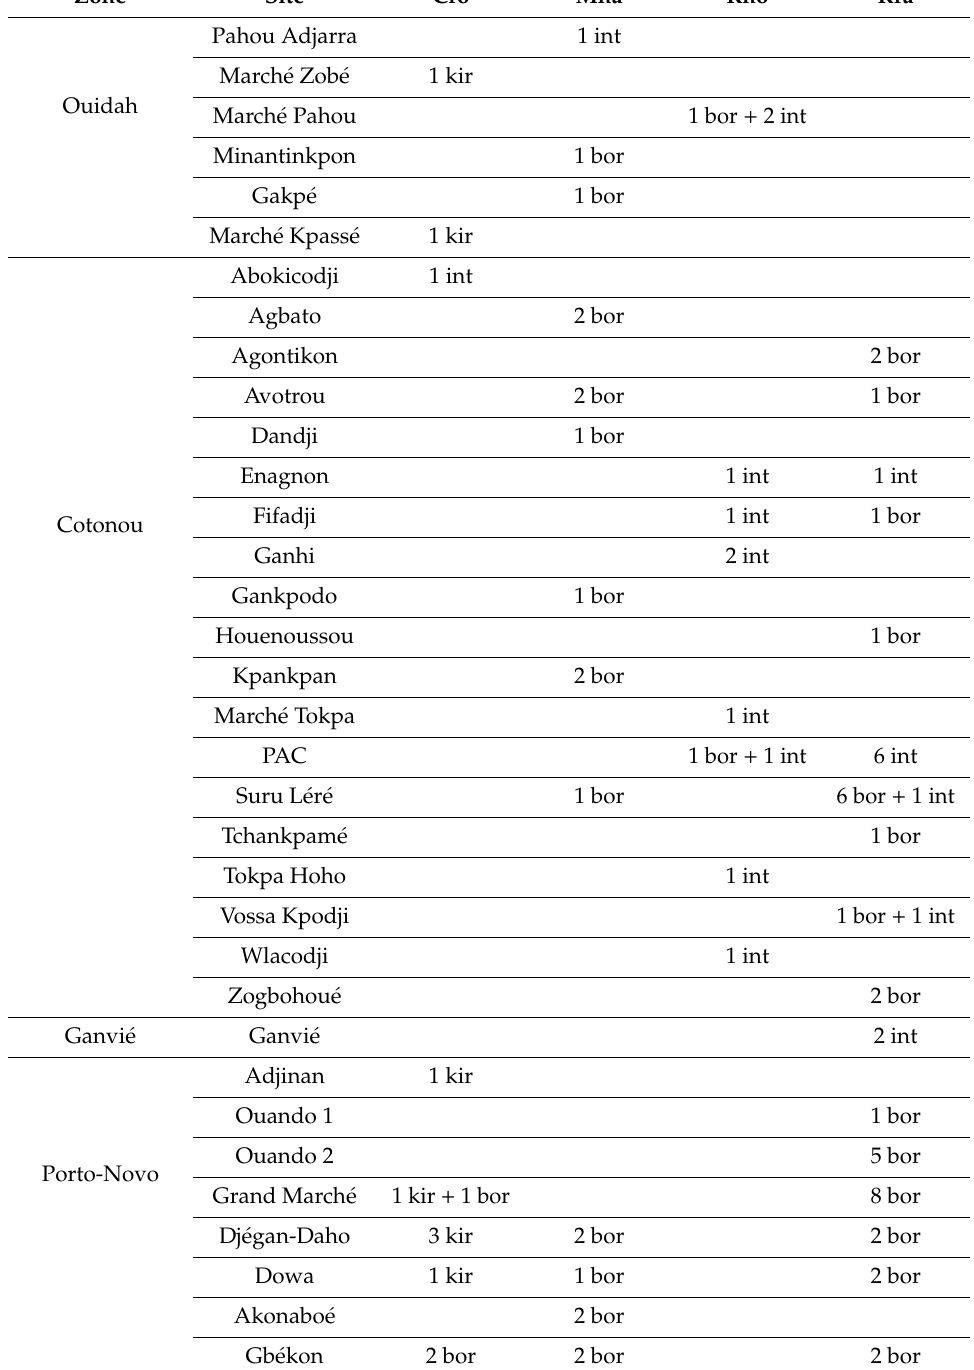
Table 2. Leptospira species (as identified by 16S sequencing) in the di ff erent host species, zones, and sites.